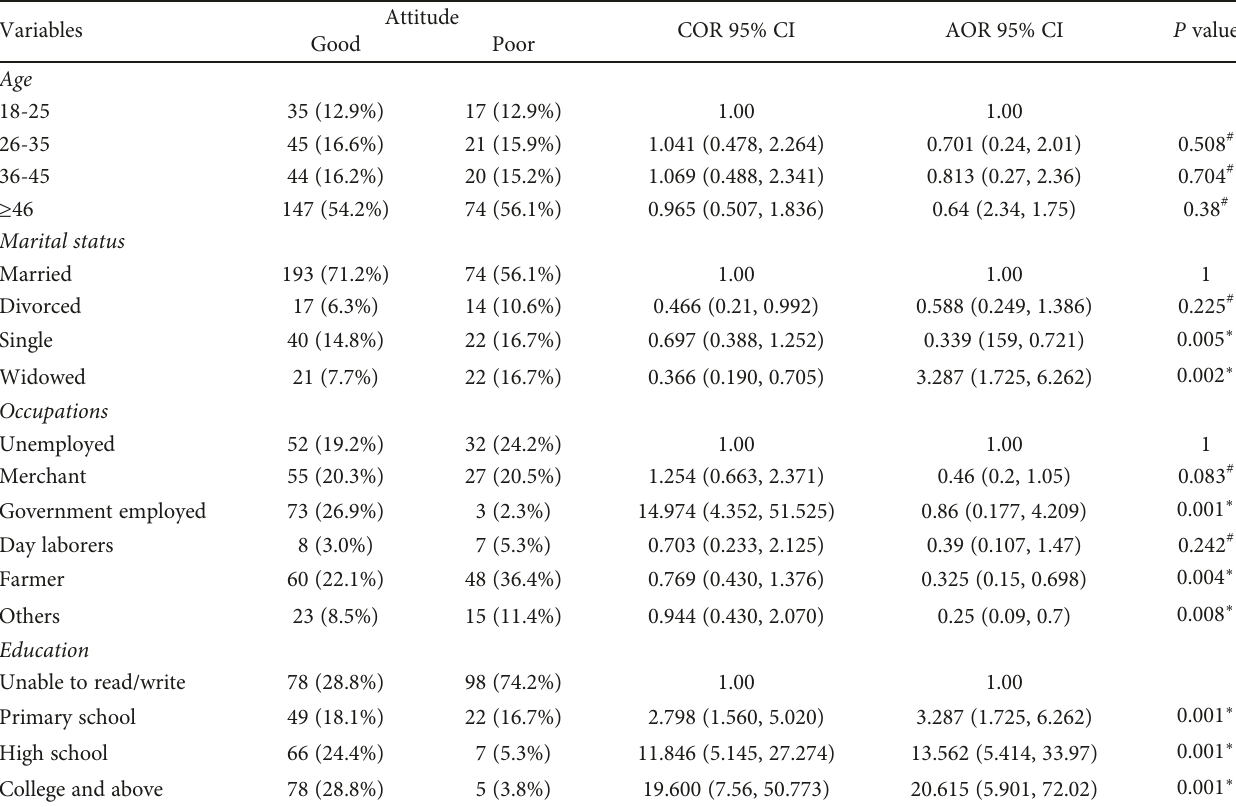
Table 6: Bivariable and multivariable analysis of factors associated with attitude towards glycemic controls on DM patients at the University of Gondar referral hospital,